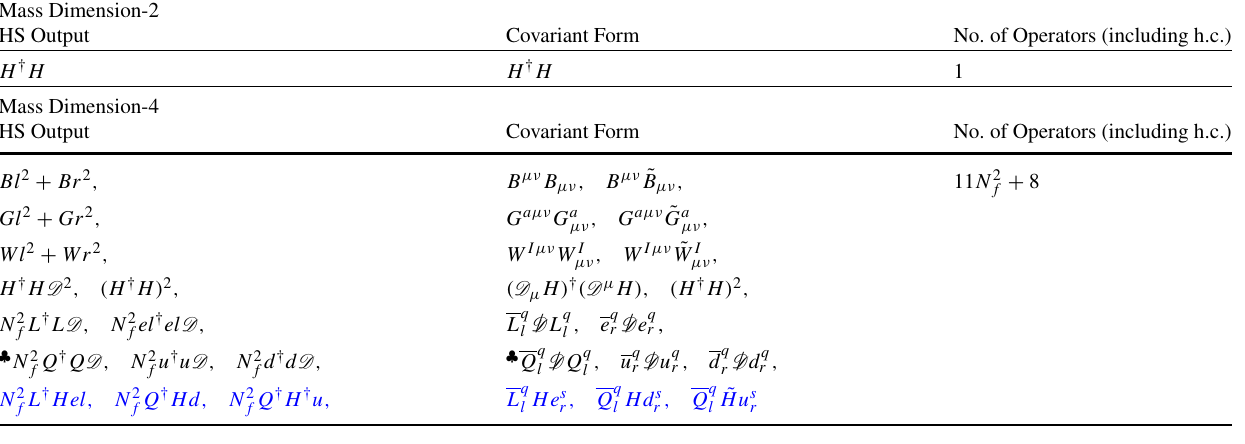
Table 22 SM: Renormalizable operators as Hilbert Series output and their covariant form. Coefficients of each operator (which appear as functions of N f ) tell us the number of all possible operators with the same structure. The operators in blue have distinct hermitian conjugates which we have not written explicitly. Here, I = 1,2,3 are SU ( 2 ) indices; a = 1,...,8 are SU ( 3 ) indices and q , s = 1 , 2 ,..., N f are flavour indices